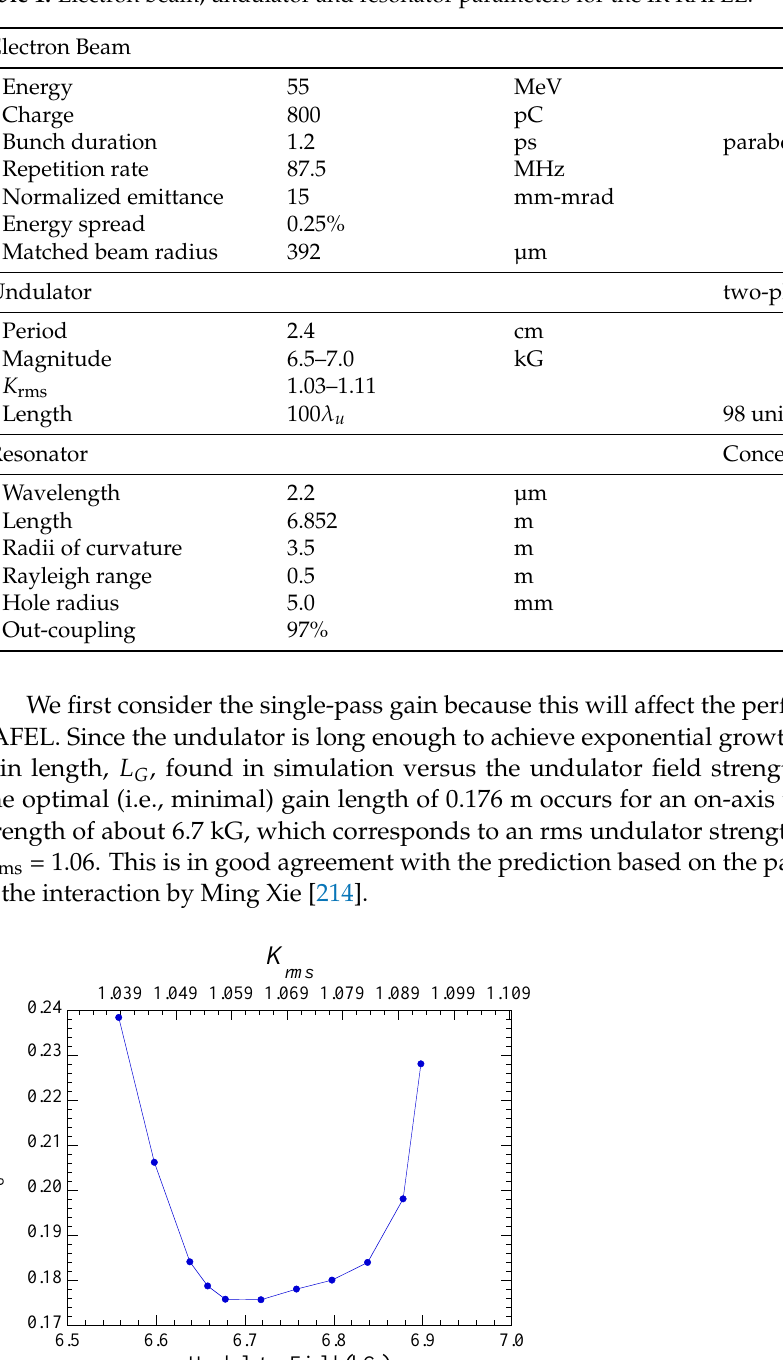
Table 1. Electron beam, undulator and resonator parameters for the IR RAFEL.